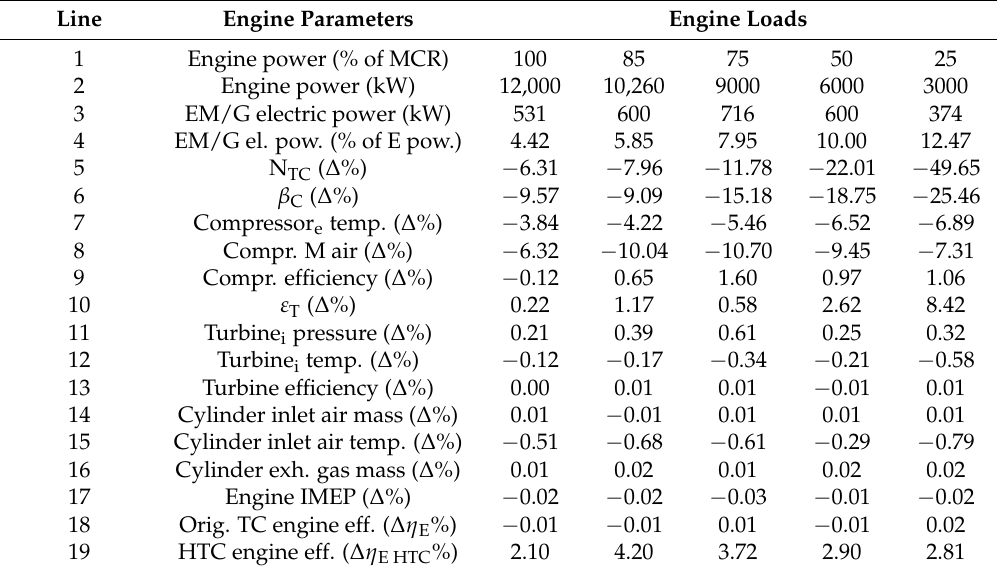
Table 2. Conventional and hybrid turbocharger comparison for different engine working points and constant speed (514